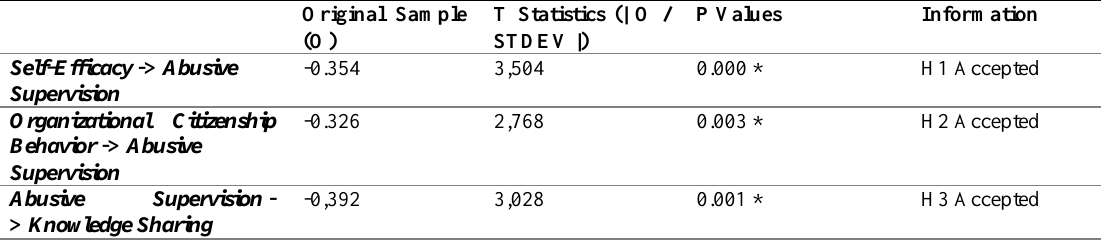
Table 6: Results of Testing the Relationship Between Constructs (Hypothesis